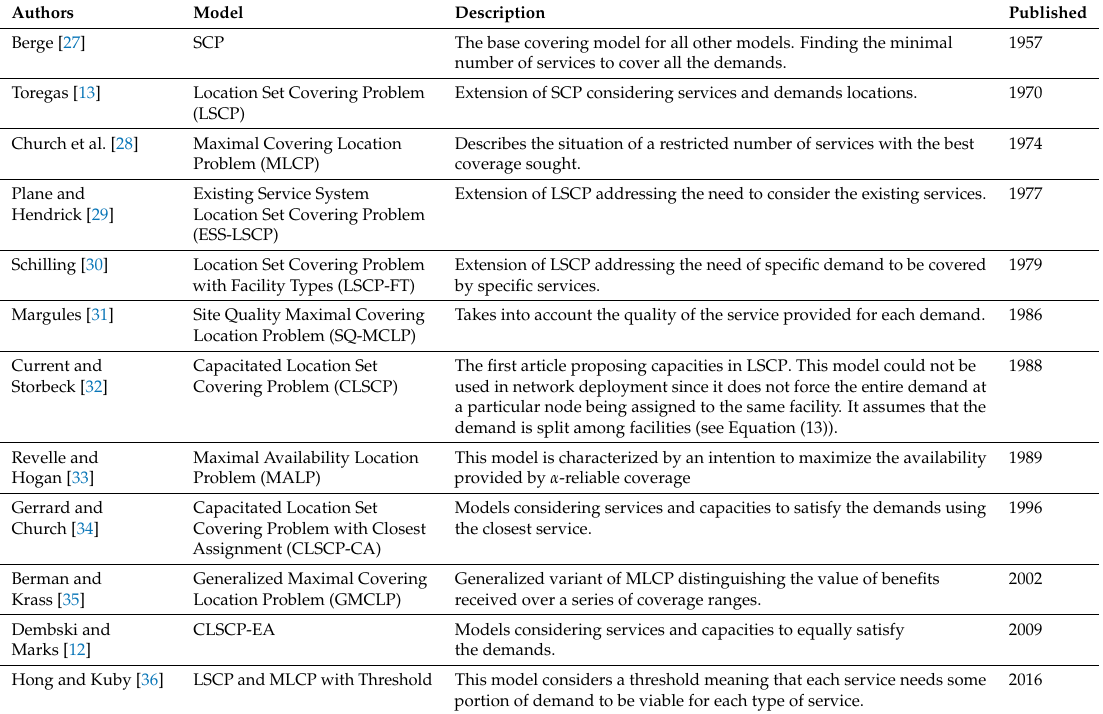
Table 2. An overview of core mathematical models for covering